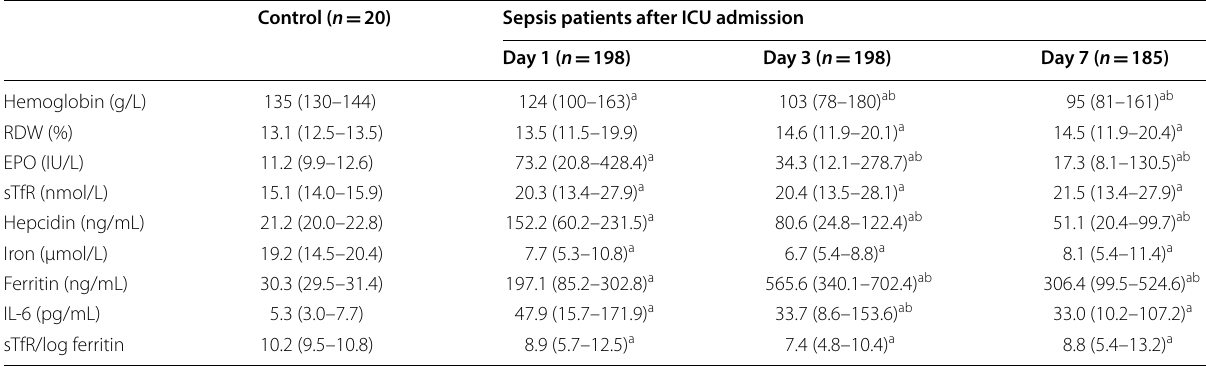
Values are the mean EPO erythropoietin; ICU intensive care unit; IL - 6 interleukin-6; RDW red blood cell distribution width; sTfR soluble transferrin receptor